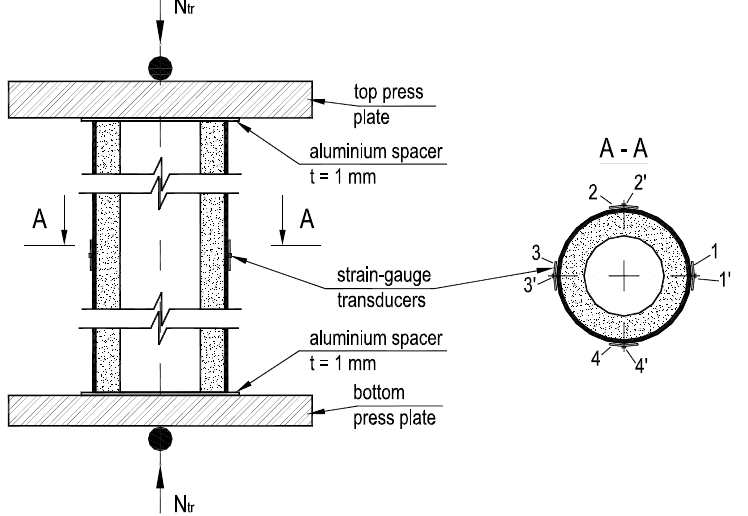
Fig 3 . The specimen fixing scheme for type I test